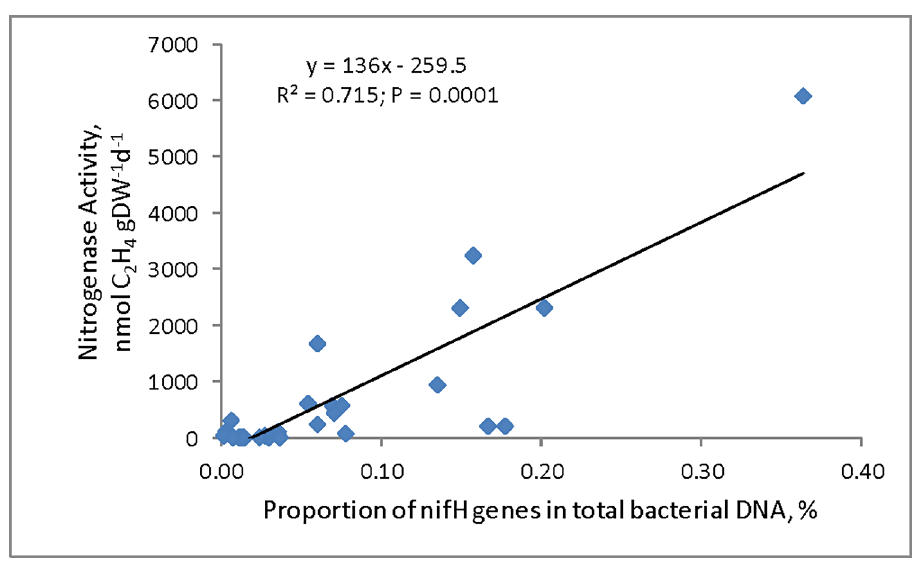
Fig 6. Relationship between nitrogenase activity expressed as ethylene production (nmol C 2 H 4 gDW -1 d -1 ) and proportion of nifH genes in total bacterial DNA. Combined data from Atitla´n case study and the cultivation